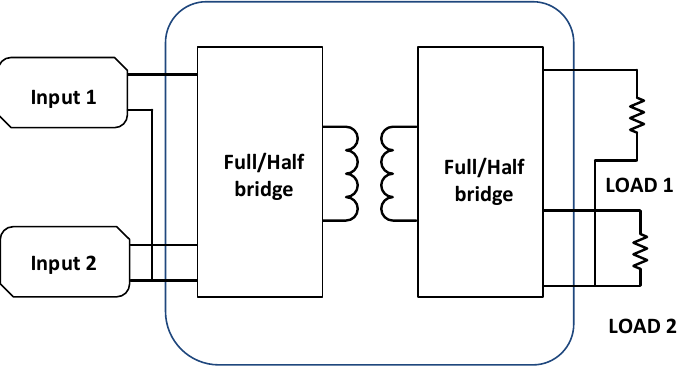
Figure 5. Structure of partially isolated double-input-double-output (DIDO) port system.